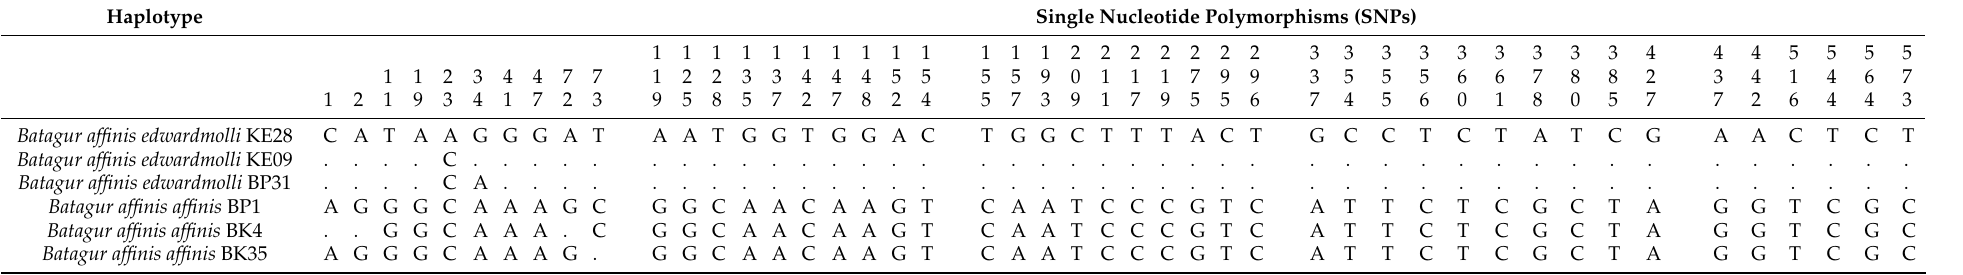
Table 1. Summary of SNPs of six observed mitochondrial DNA D-loop haplotypes of Batagur affinis . We designated the corresponding number to each SNPs with the first base of the mtDNA control region [65]. Dots indicate identity to the KE28 haplotype